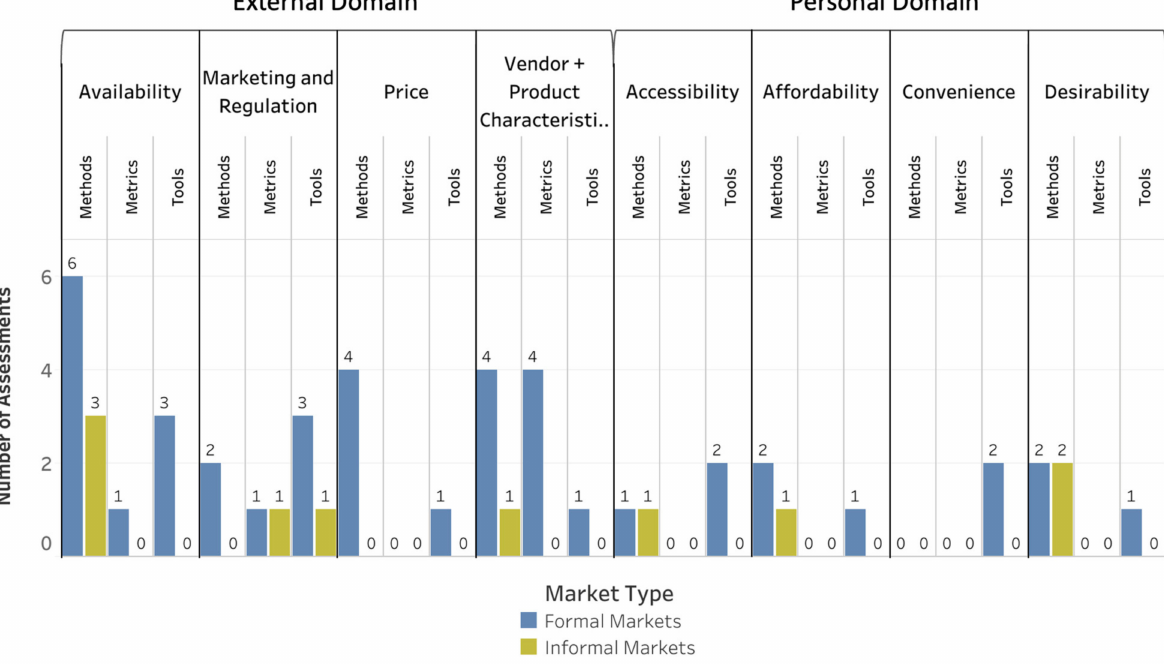
Figure 3. Market Food-Environment Assessments Suitable for LMICs without Modification. Number of methods, tools, and metrics found suitable based on the scoring exercise without modification in